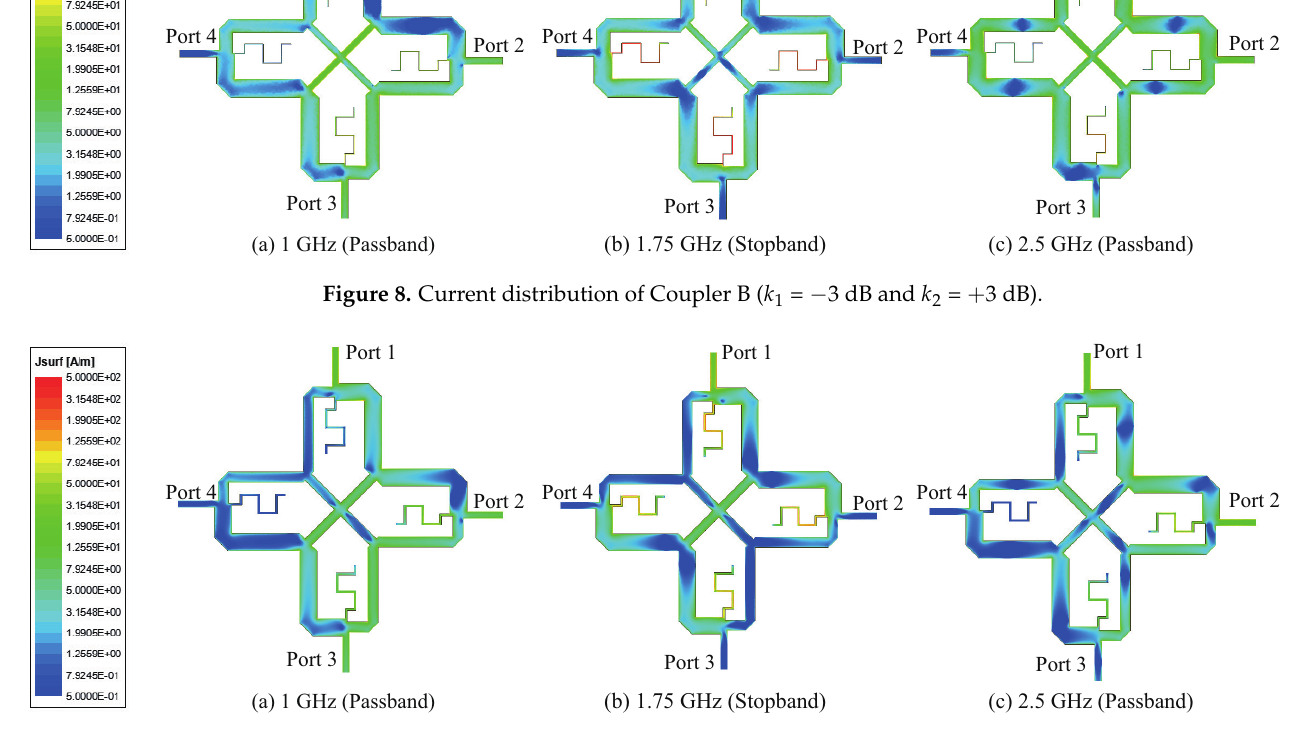
Figure 9. Current distribution of Coupler C ( k 1 = 0 dB and k 2 = + 13